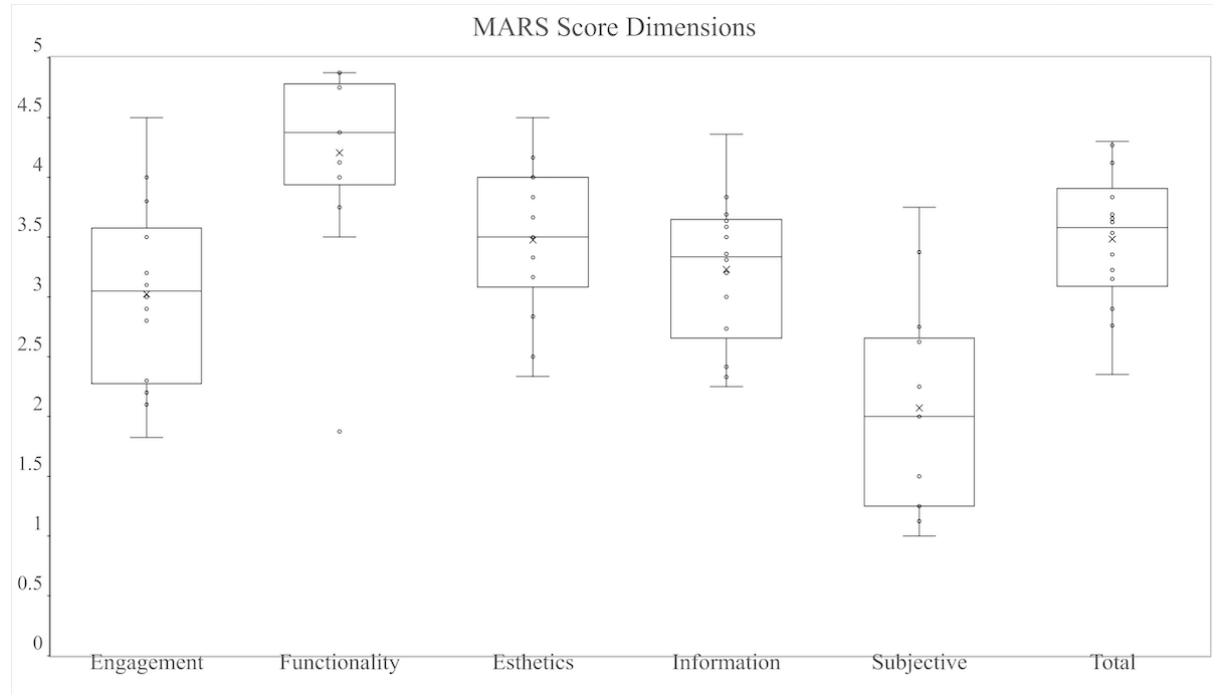
Figure 2. Mobile App Rating Scale (MARS) dimension